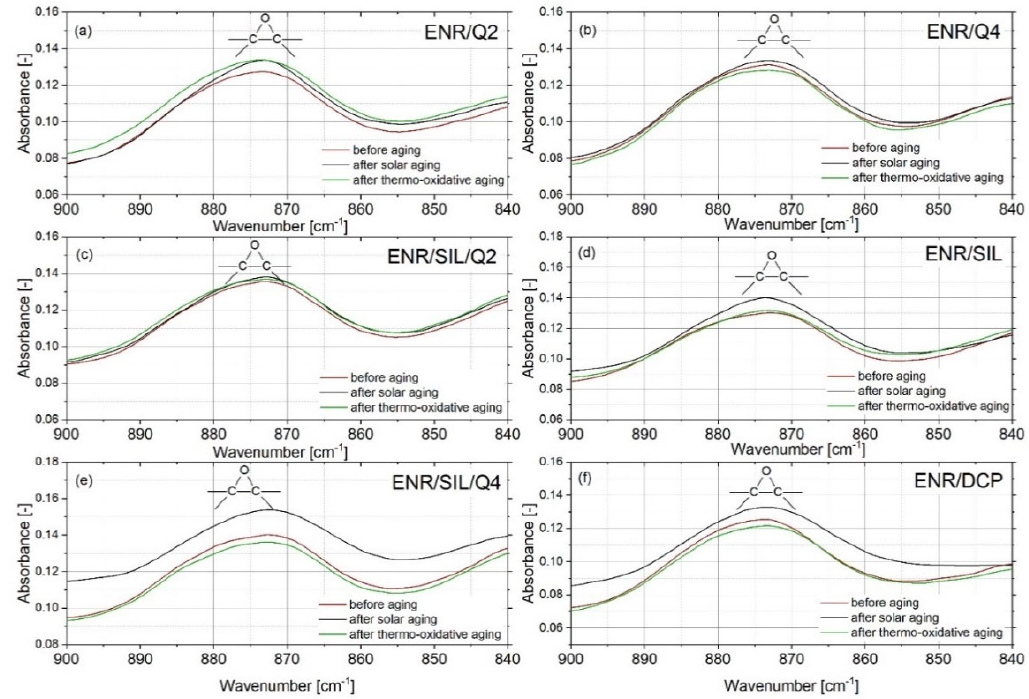
Figure 8. FT-IR spectra near oxirane rings of ENR with 2 phr of quercetin ( a ), ENR cured with 4 phr of quercetin ( b ), ENR cured with combination of 2 phr of quercetin and silica ( c ), with silica ( d ), with combination of 4 phr of quercetin and silica ( e ) and ENR-50 cured with DCP before and after solar as well as thermo-oxidative aging ( f